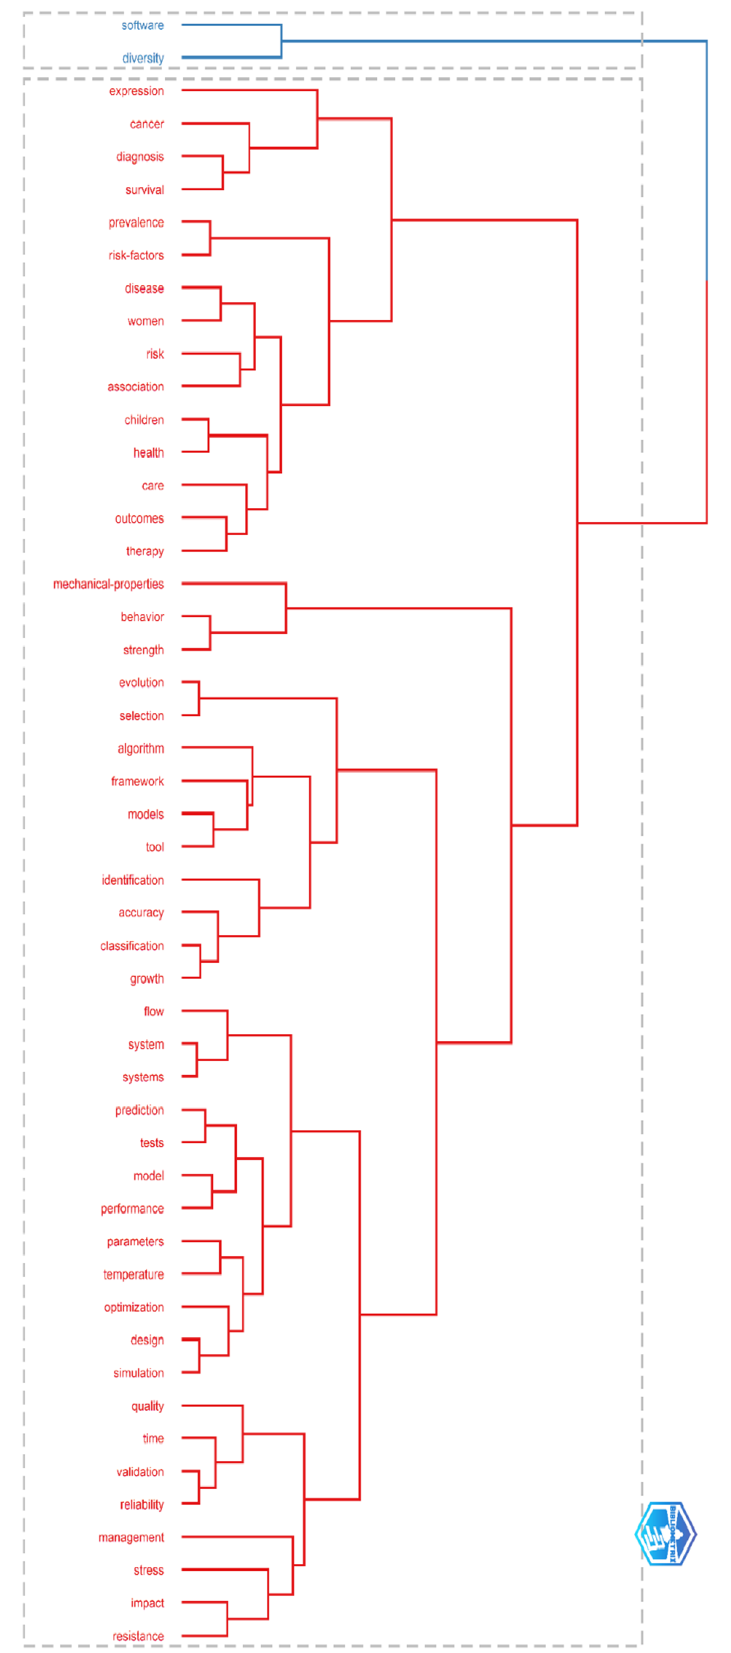
Figure 21. Topic Dendrogram for the years 2019–2021.